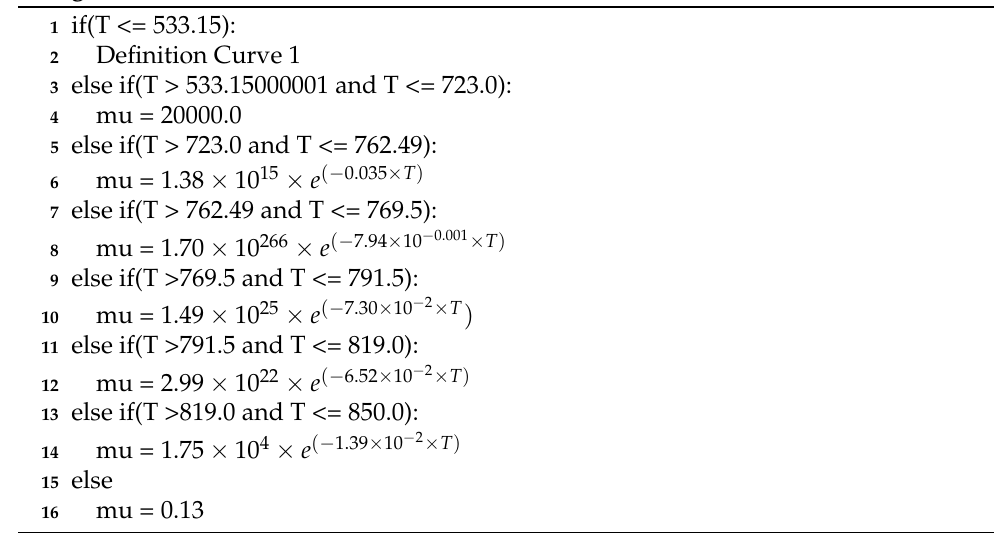
Algorithm A2: Definition of the curve 2.